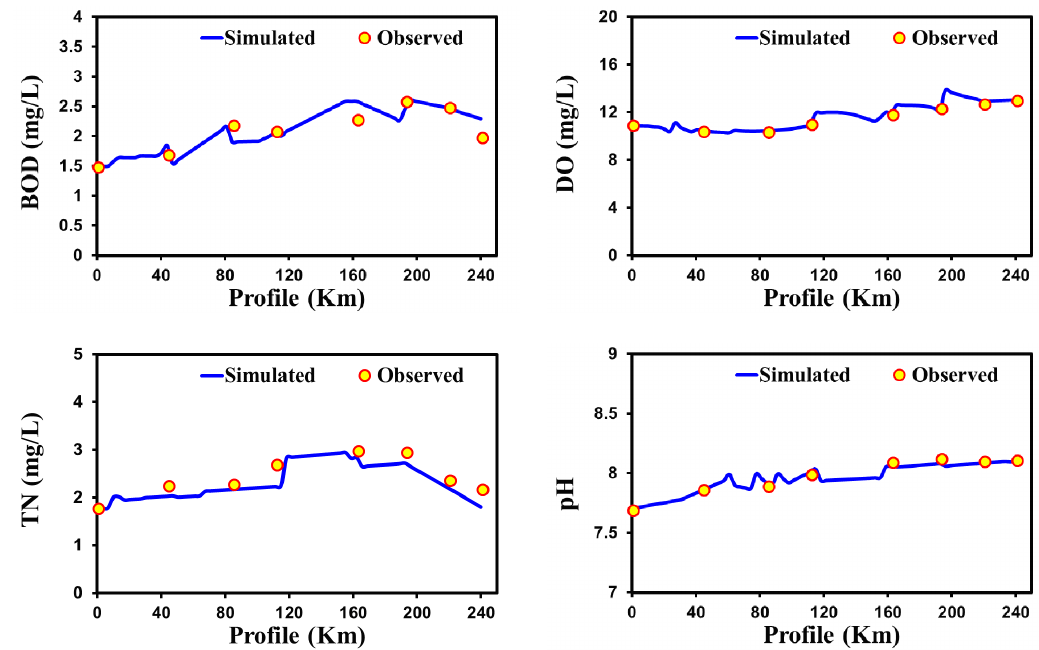
Figure 7. Confirmation of water quality model results in the Nakdong River (cold climatic region) for BOD, DO, TN, and pH.